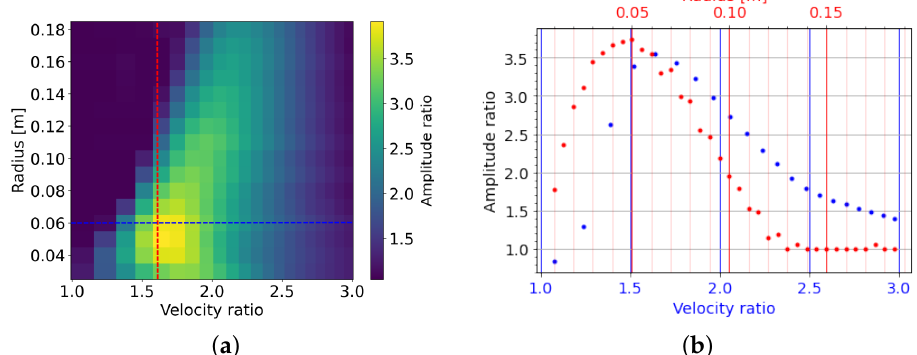
Figure 6. Amplitude ratio between reflections (A) and (B) for ( a ) different radius and velocity ratios between surrounding media and cylinder. ( b ) Amplitude ratio variation with radius for a velocity ratio set to 1.62 (red dots and red line in ( a )) and amplitude ratio as a function of velocity ratio with the radius set to 0.06 m (blue dots and blue line in ( a )).